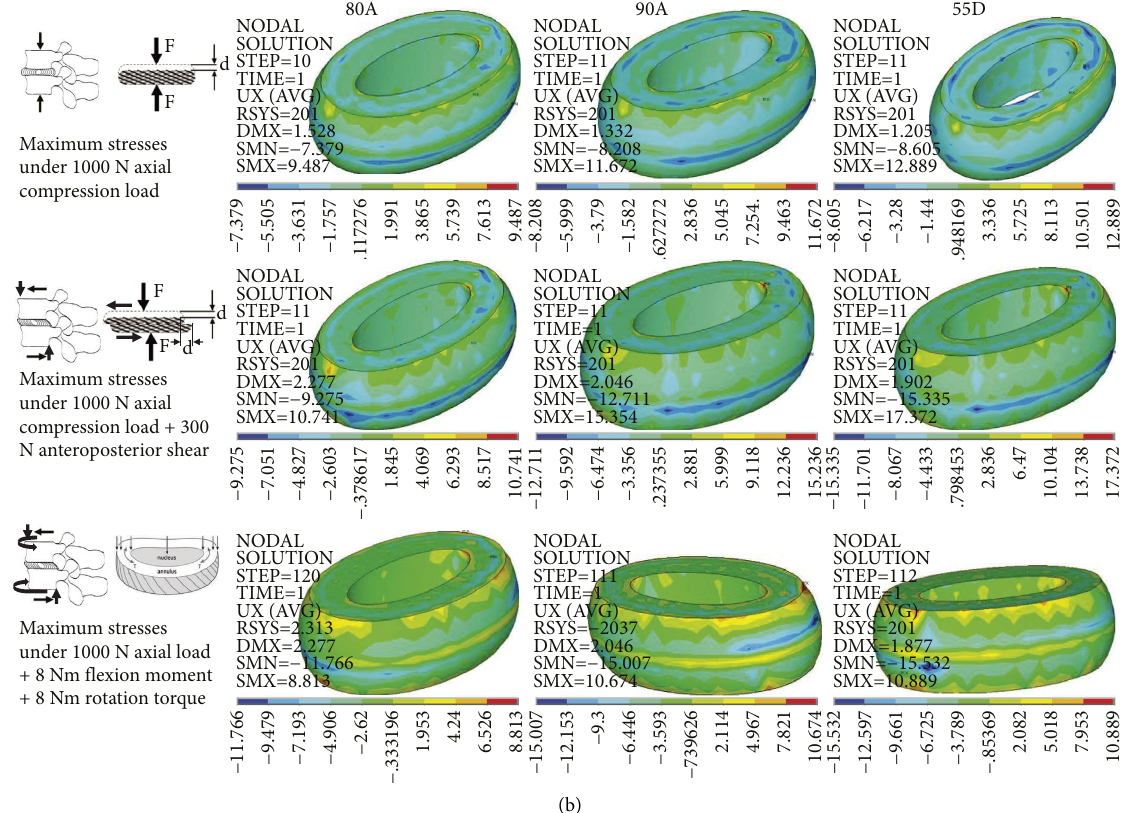
Figure 6: (a) Monobloc design selected and (b) coronal section. Nucleus replacement biomechanical characteristics comparing the three Bionate ® chosen types.